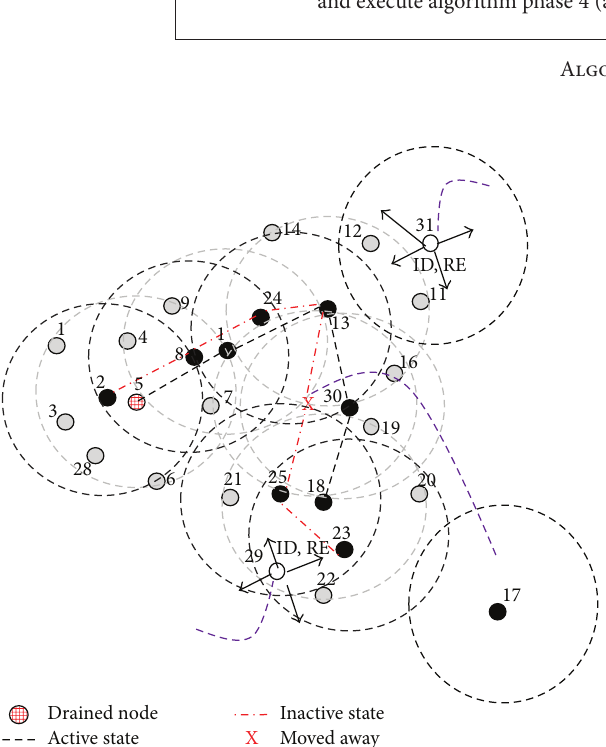
Figure 6: The energy efficient optimal CDS maintenance phase after Δ𝑇 time with new nodes 29 and 31. Moved-out node 17, drained-out node 5.